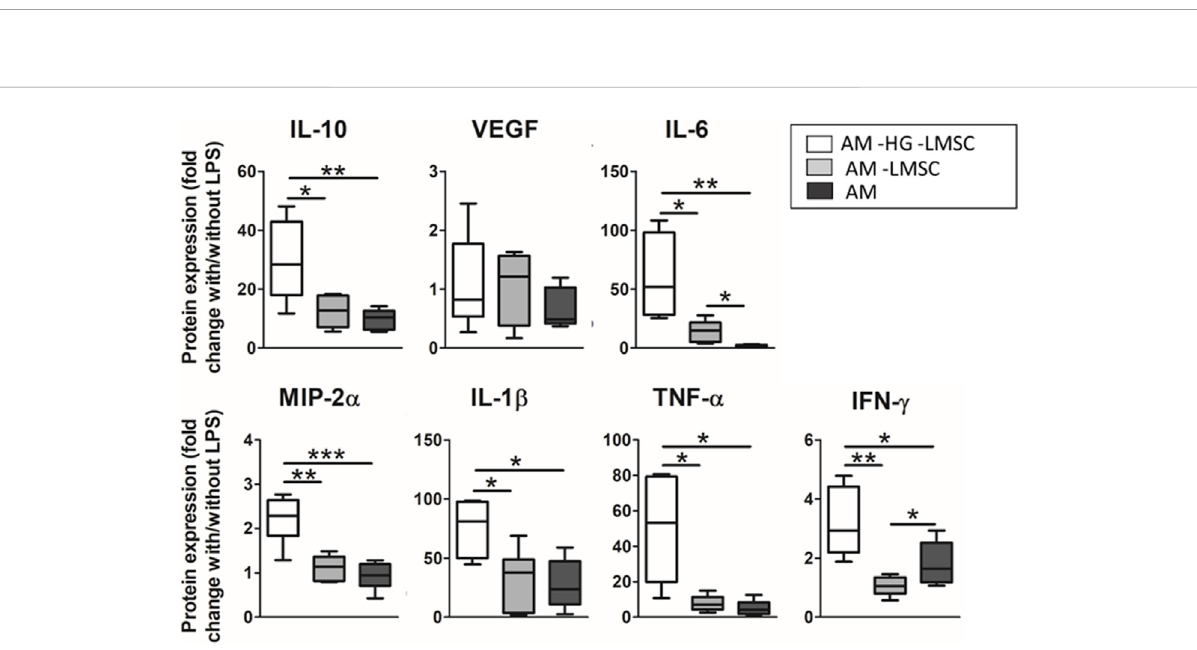
FIGURE 8 Effect of LMSC and hydrogel on the secretion of cytokines. Three groups were studied: ATII on PDMS with cyclic stretch (AM-HG-LMSC), ATII on hydrogel with cyclic stretch (AM-LMSC), and ATII on hydrogel with 3D LMSC cultured inside in the presence of cyclic stretch